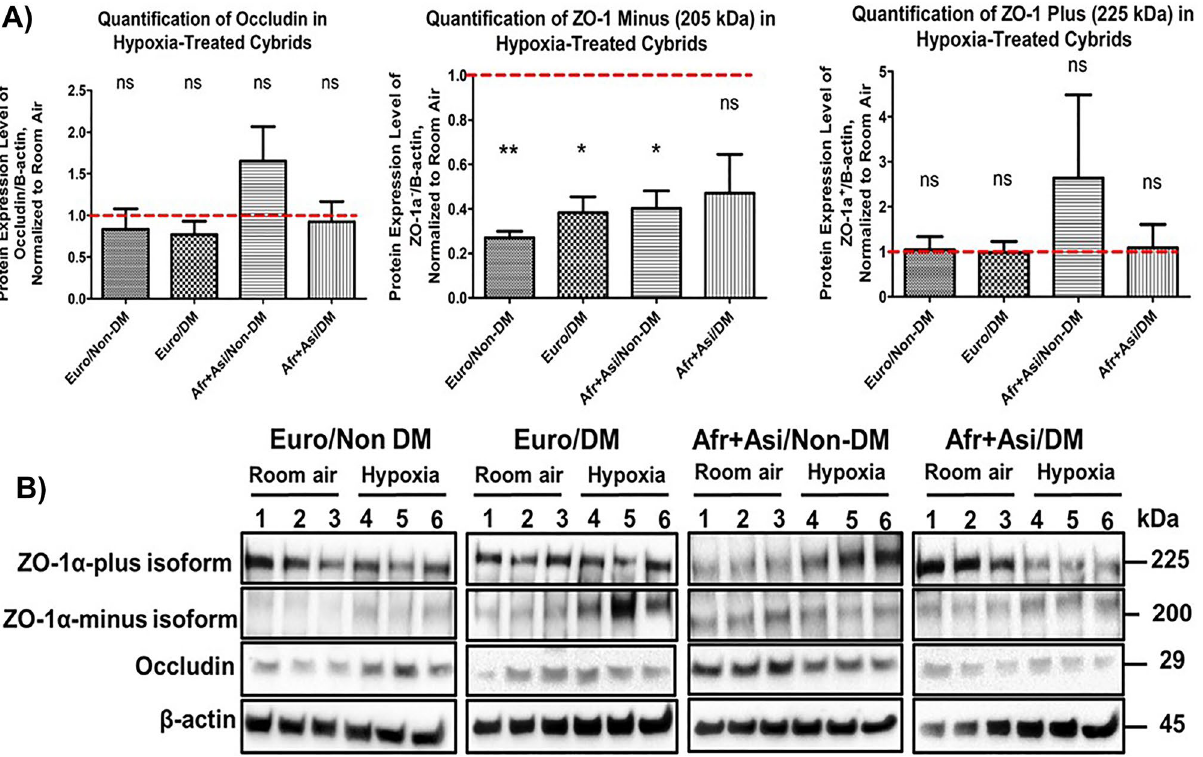
Figure 4. Tight junction protein levels are similarly changed in hypoxia for European and [Afr + Asi], DM and Non-DM cybrids. Tight junction proteins in our cybrids cultured 48 h ± 2% O 2 was measured using a western blot assay for ( A ) occludin, ( B ) the 205 kDa ZO-1α-minus isoform, and ( C ) the 225 kDa ZO-1α-plus isoform. For both groups of cybrids, data were normalized to protein levels in cybrids cultured in room air (red dotted line, value = 1). Afr + Asi = African + Asian; Euro = European; DM =